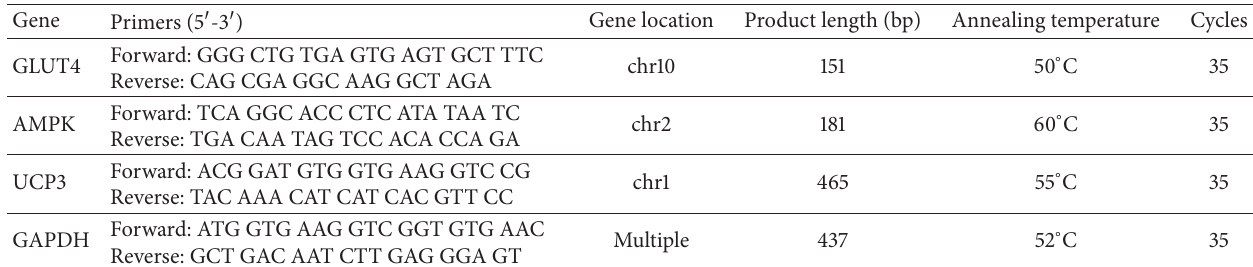
Table 1: Primers and PCR conditions used for